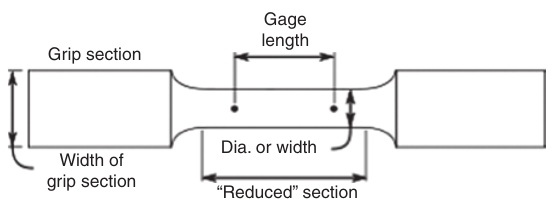
Figure 2 Specimen of tension test.